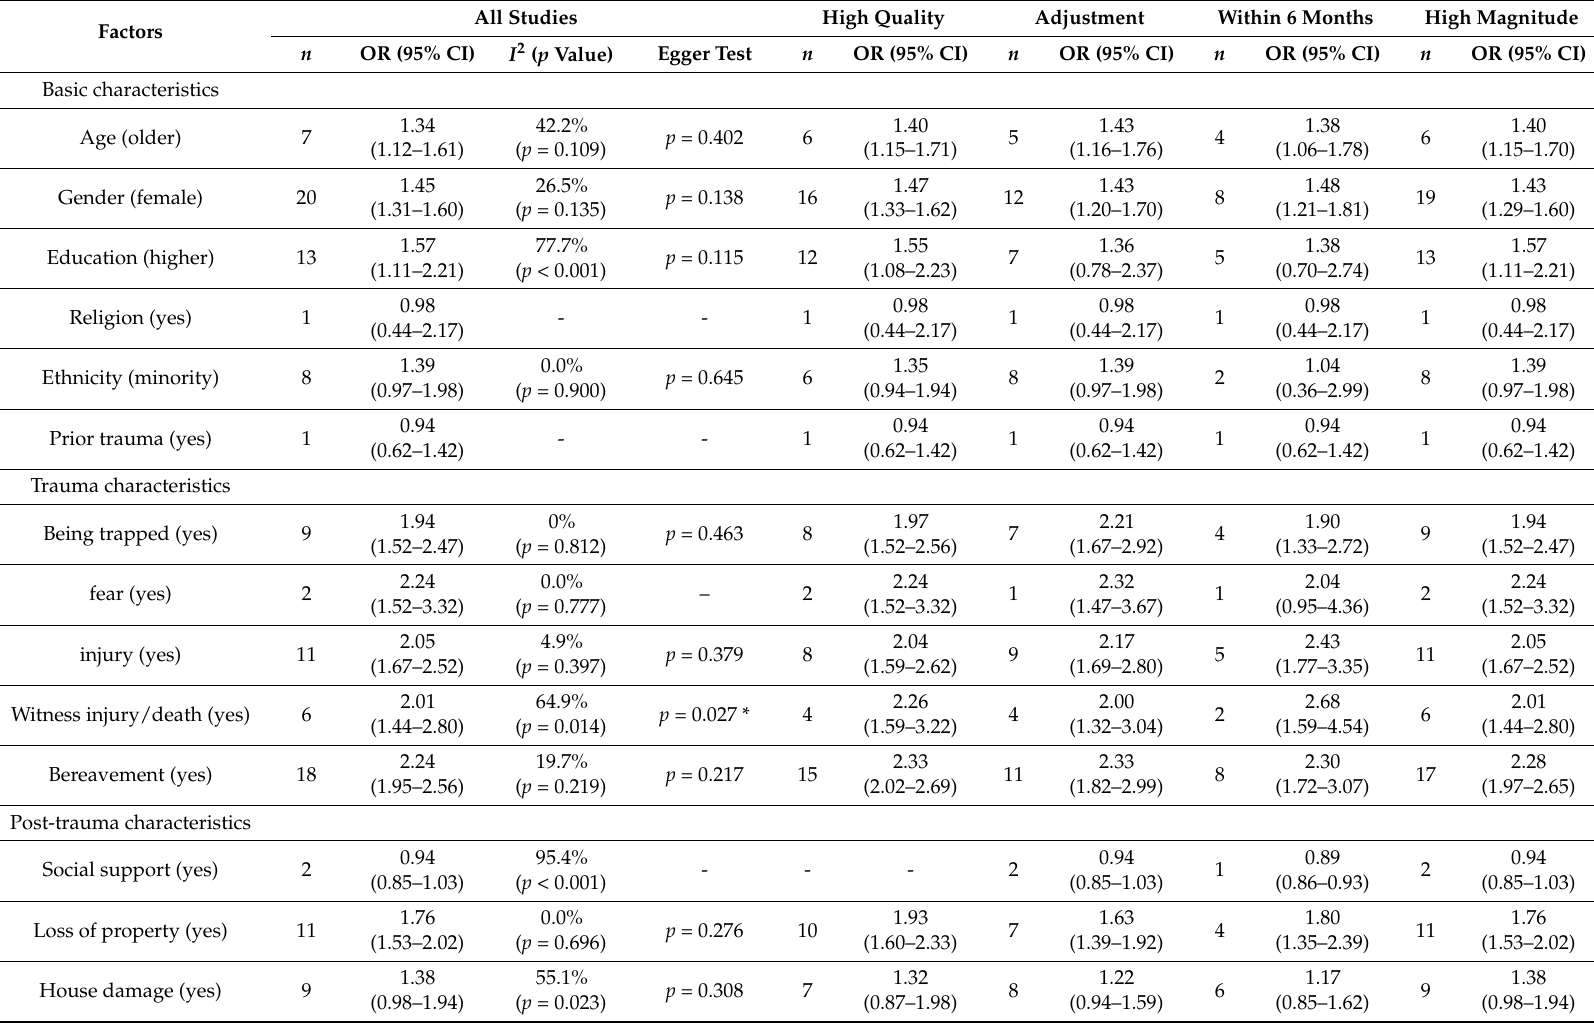
Table A3. Risk Factors for PTSD after earthquakes in